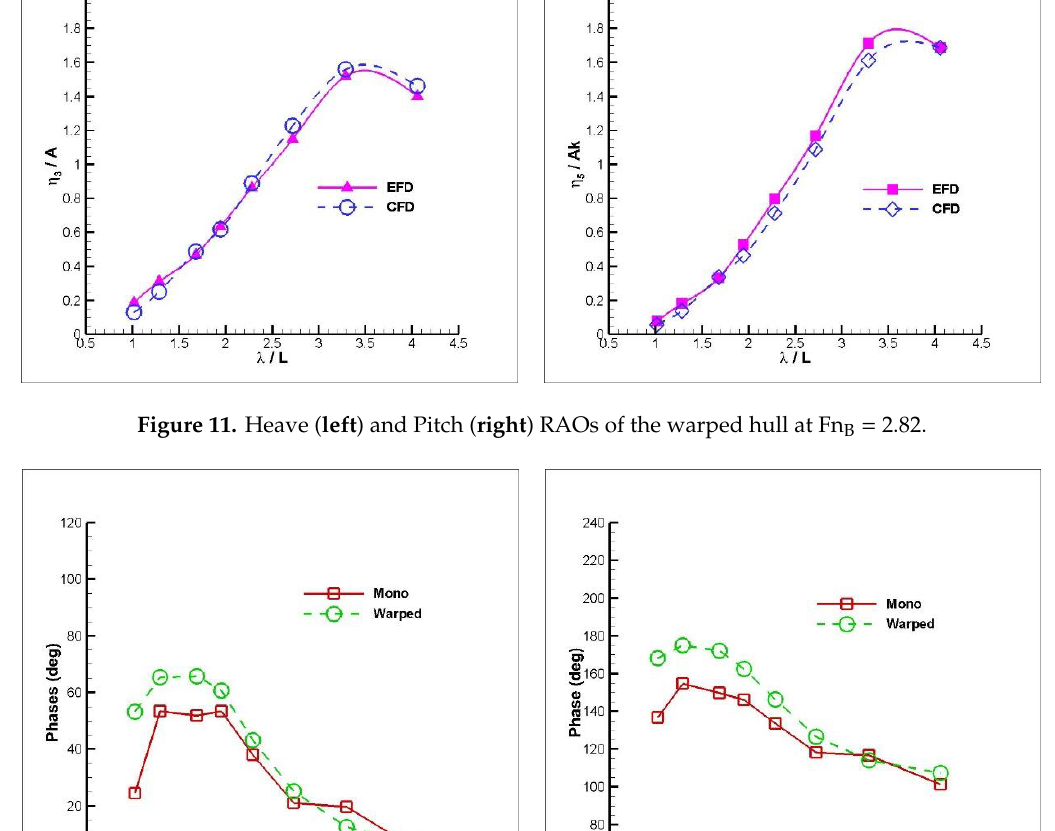
Figure 12. Phases of heave ( left ) and pitch ( right ) for both models at Fn B = 1.67.